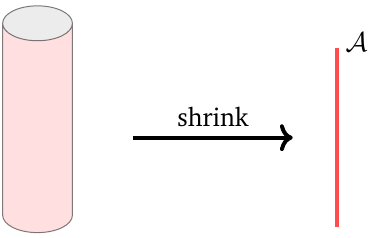
Figure 1: Anyon from gapped boundary A